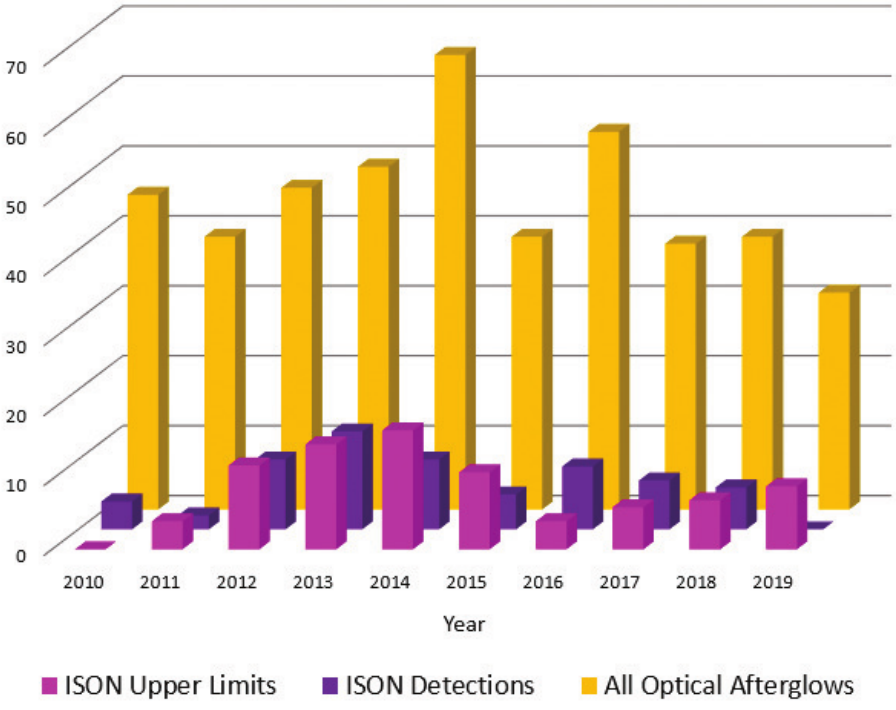
Figure 2. Statistics of the ISON network contribution to the worldwide optical observations of GRB afterglows. The bars indicate (from background to foreground) worldwide amount of GRB optical afterglows discovered, the detections made by ISON network, and the upper limits obtained by the ISON telescopes without detecting any optical